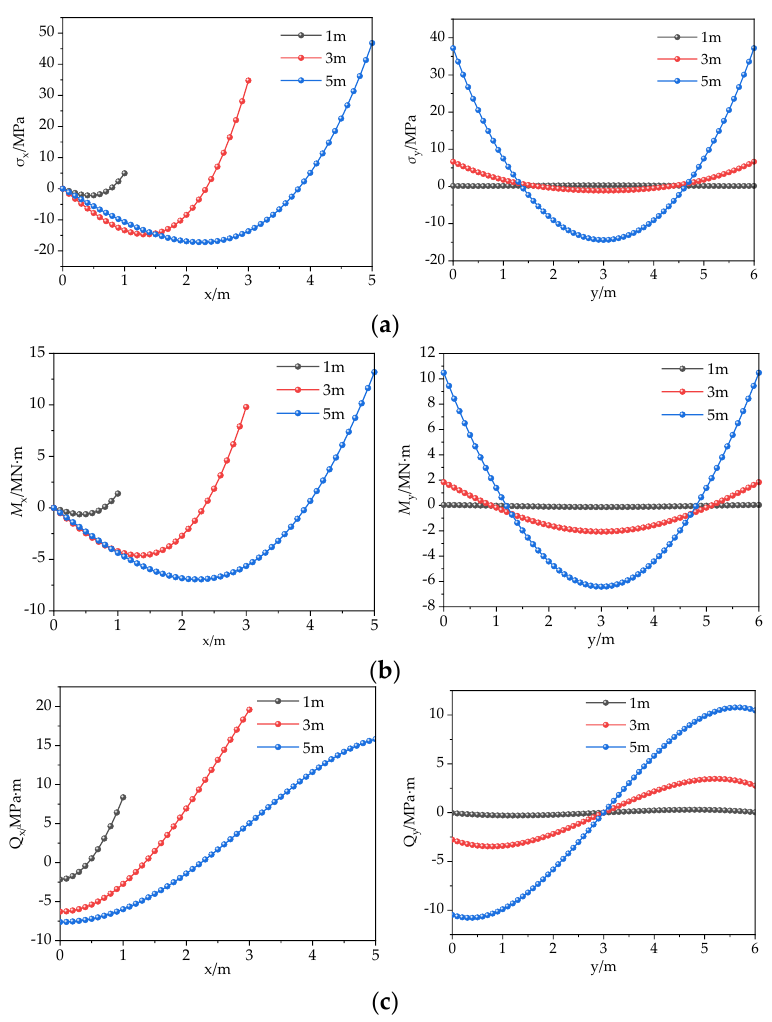
Figure 4. Relationship between roof force and unsupported distance in heading face: ( a ) stress; ( b ) bending moment; ( c ) transverse shear stress.